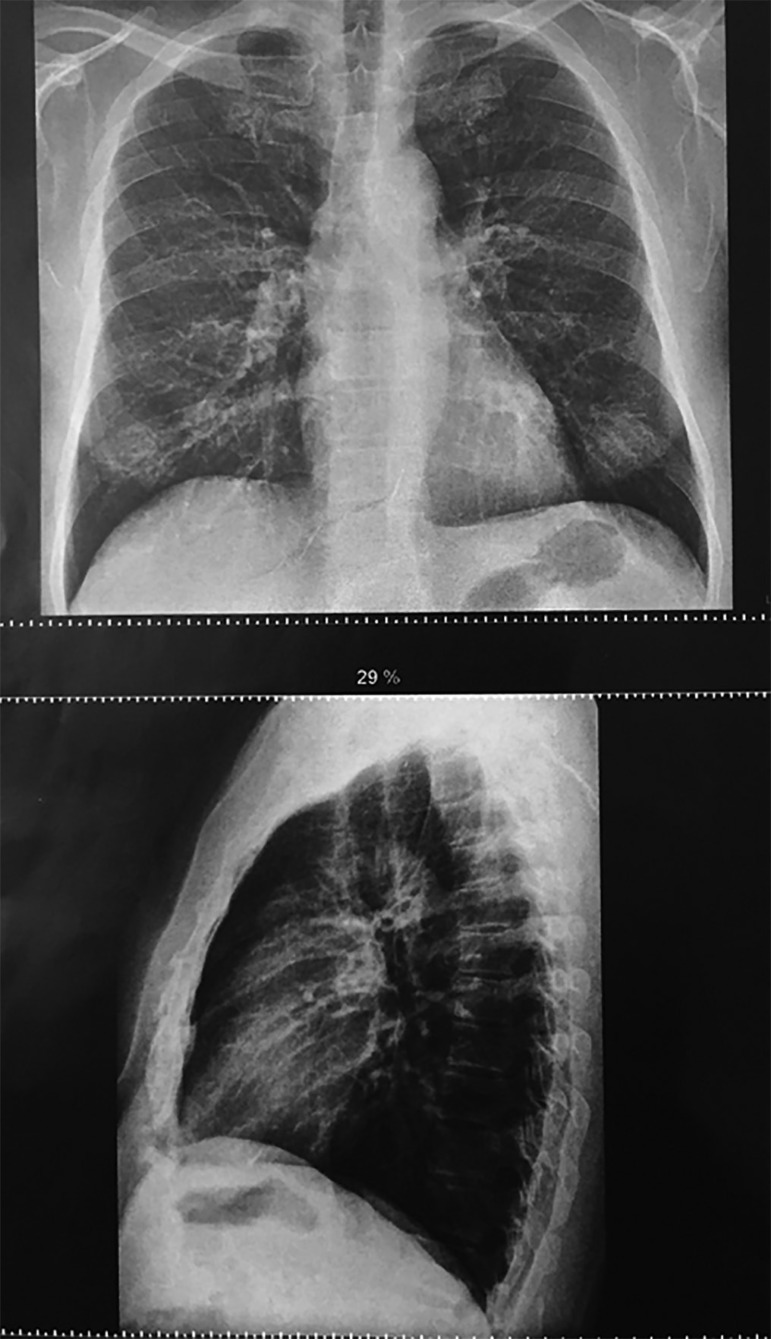
Chest X-ray: outpatient follow-up.